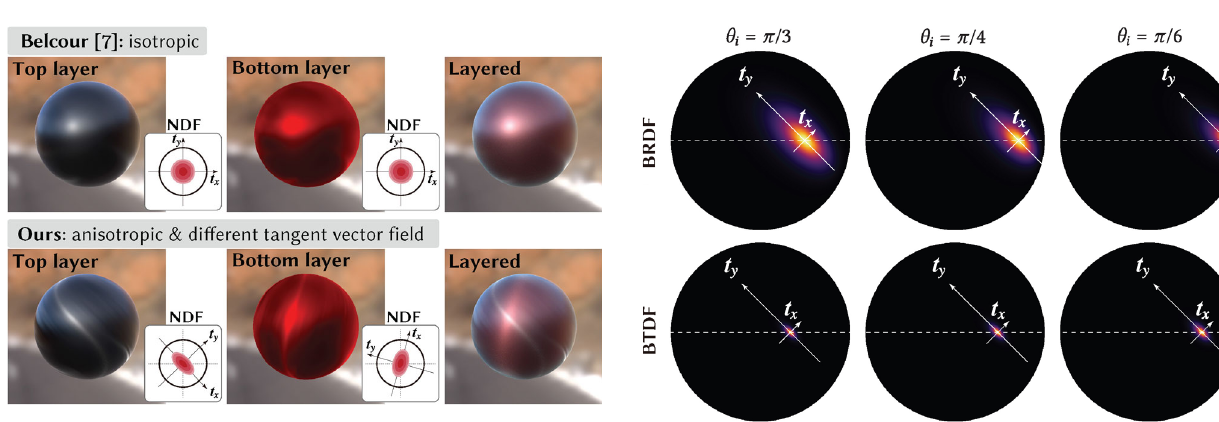
Fig. 3 Visualizations of projected distributions for BSDFs with different incident zenith angles. The distributions are calculated with a GGX normal distribution indicated in the center of Fig. 2. In this figure, the Fresnel terms for conductors and dielectrics are omitted for only focusing on material-independent BSDF